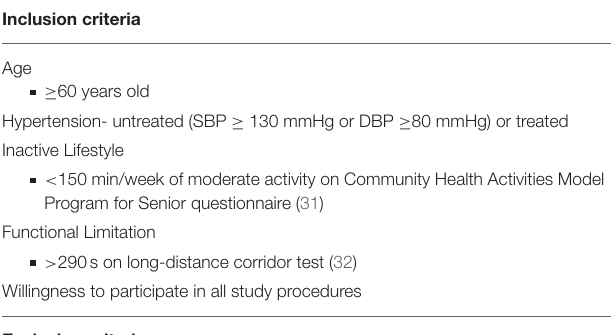
TABLE 1 | Inclusion and Exclusion criteria for the ACES trial. Inclusion